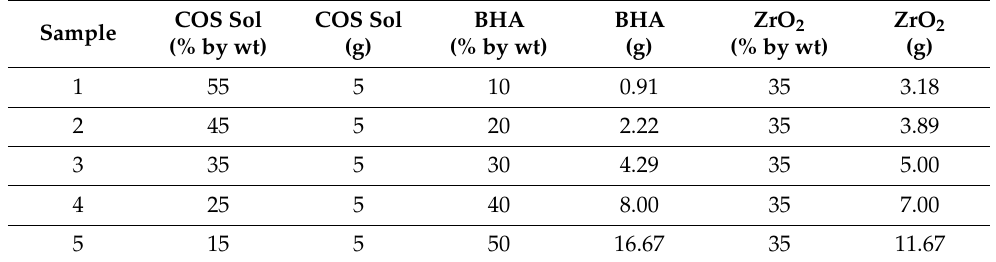
Table 1. Proportions of COS, BHA, and ZrO 2 via percentage by weight (wt) for each investigated